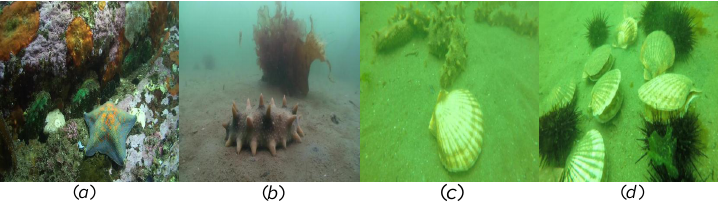
Figure 13. URPC2020 dataset includes four biological categories, namely ( a ) starfish, ( b ) holothurian, ( c ) scallop, and ( d )